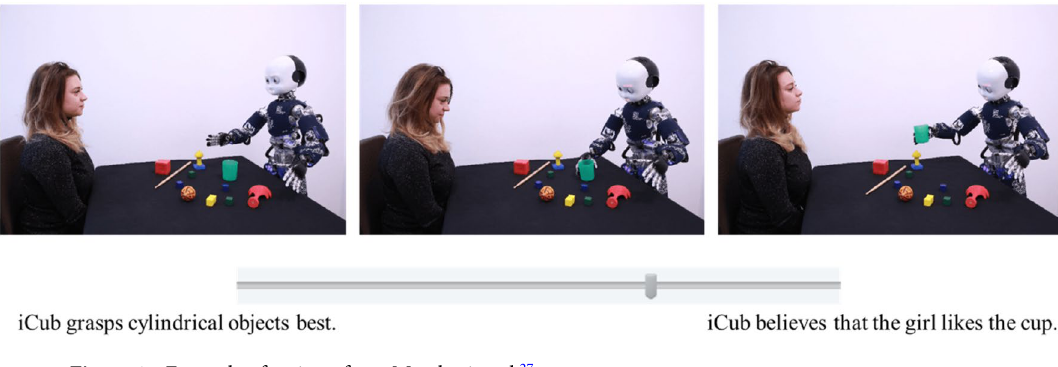
Figure 1. Example of an item from Marchesi et al. 27